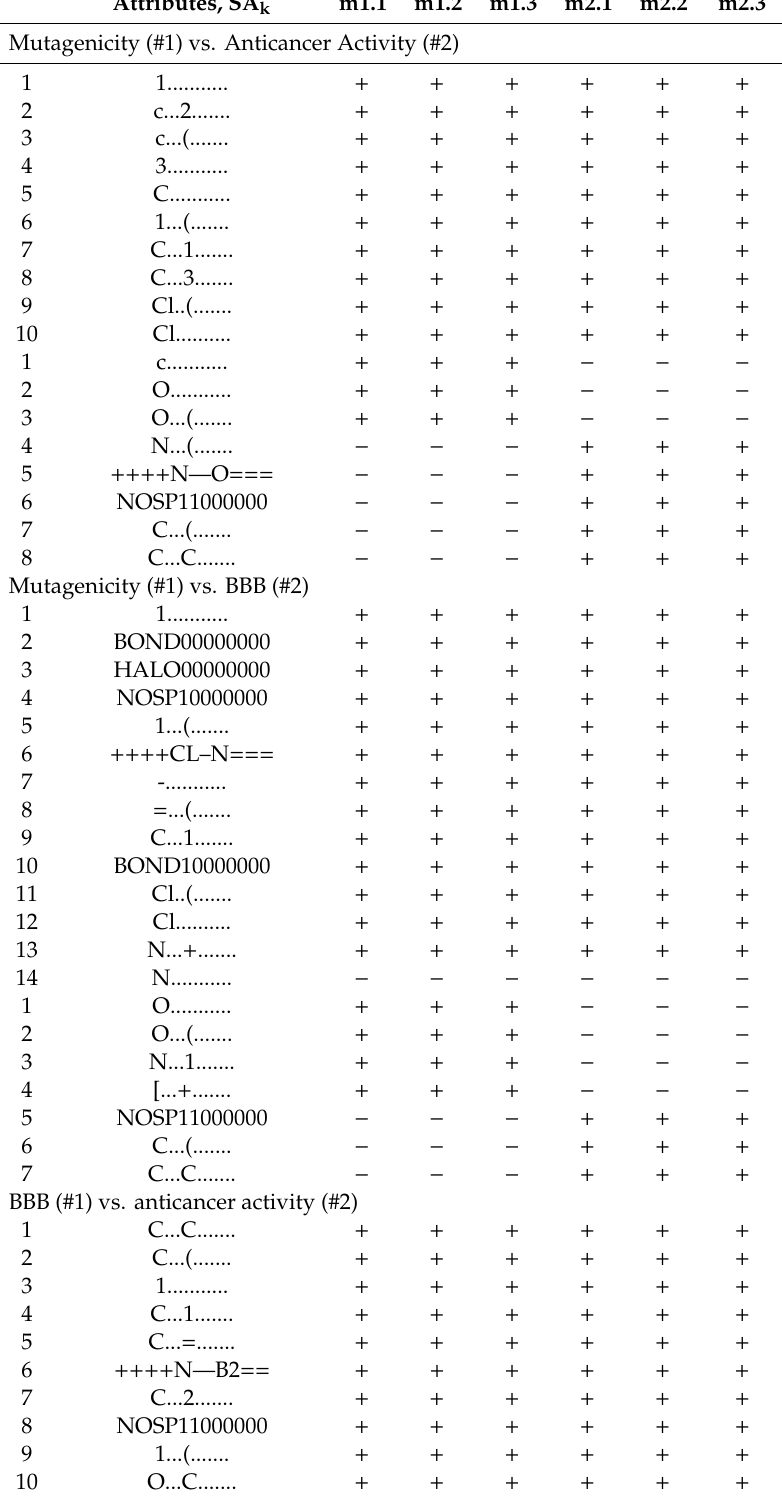
Table 6. Definition of similarities to models for mutagenicity, anticancer activity and blood–brain barrier (BBB). Here, model-1, denoted m1; model-2, denoted m2. The “m1.1” means first run of optimization for endpoint 1. Each plus denotes a promoter of an increase for endpoints (#1 or #2). Each minus denotes a promoter for a decrease for endpoints (#1 or